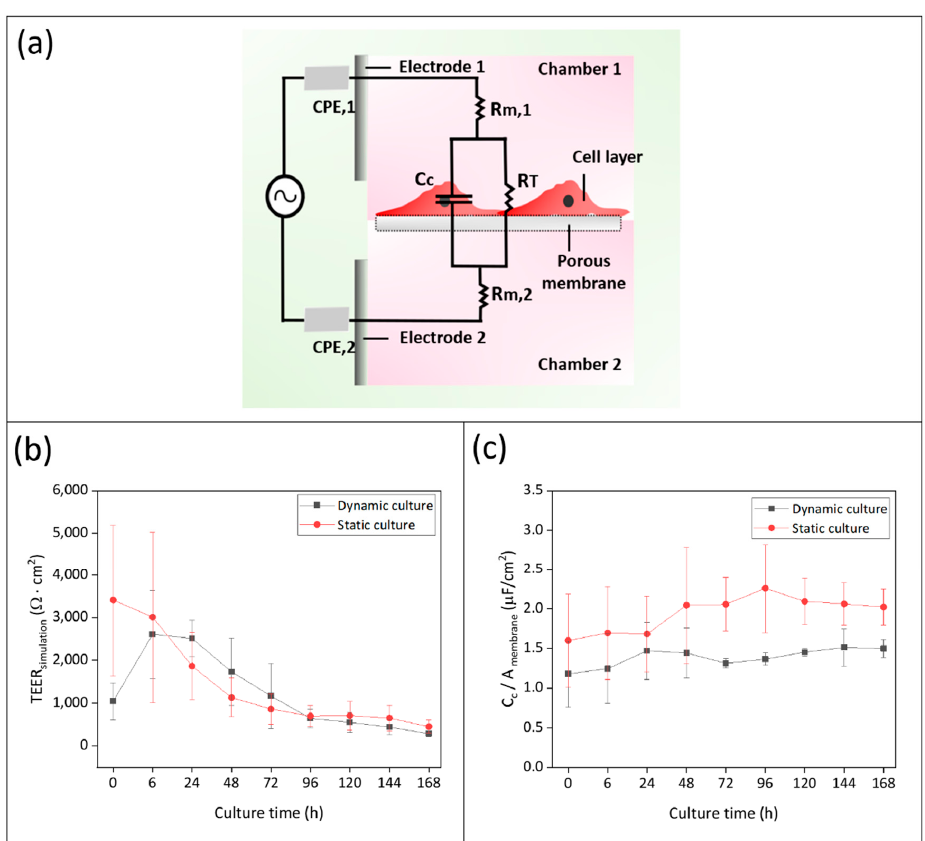
Figure 6. EIS measurement for monitoring of hiPSC-derived BCECs culture over 168 h in dynamic and static conditions (biological replicates N = 7 (0 h–48 h) and N = 3 (72 h–168 h)). ( a ) Equivalent circuit design based on the bioreactor culture system: CPE constant phase element of electrode, Cc : capacitance of cell membrane, R T : Resistance of tight junction barrier ( TEER simulation ), R m : resistance of culture medium; ( b ) results of fitted TEER simulation ; and ( c ) cell membrane capacitance obtained by fitting and simulation of impedance data. Graphs show a comparison between dynamic and static culture over the period of culture.